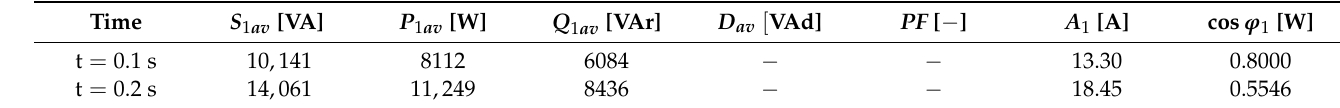
Table 30. Classical calculation before and after the change (at steady states).